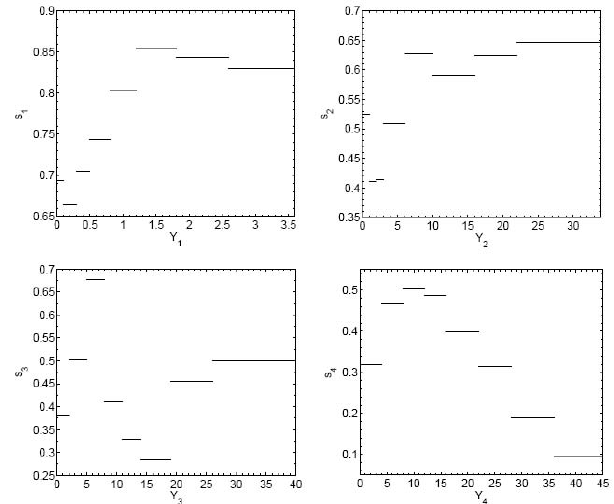
Fig. 6. Rank-ordered spectra for the scaling exponents s i (Y i ) of the four regimes, with i = 1, 2, 3 and 4 corresponding to the regime number. The extent of the horizontal lines indicates the ranges in Y i over which the scaling exponent s i is